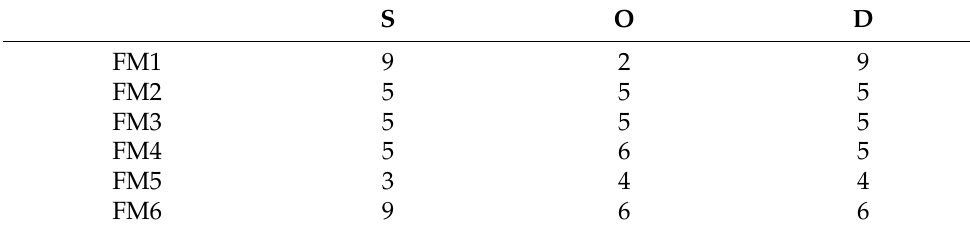
Table 7. Failure modes scores based on SOD factors.